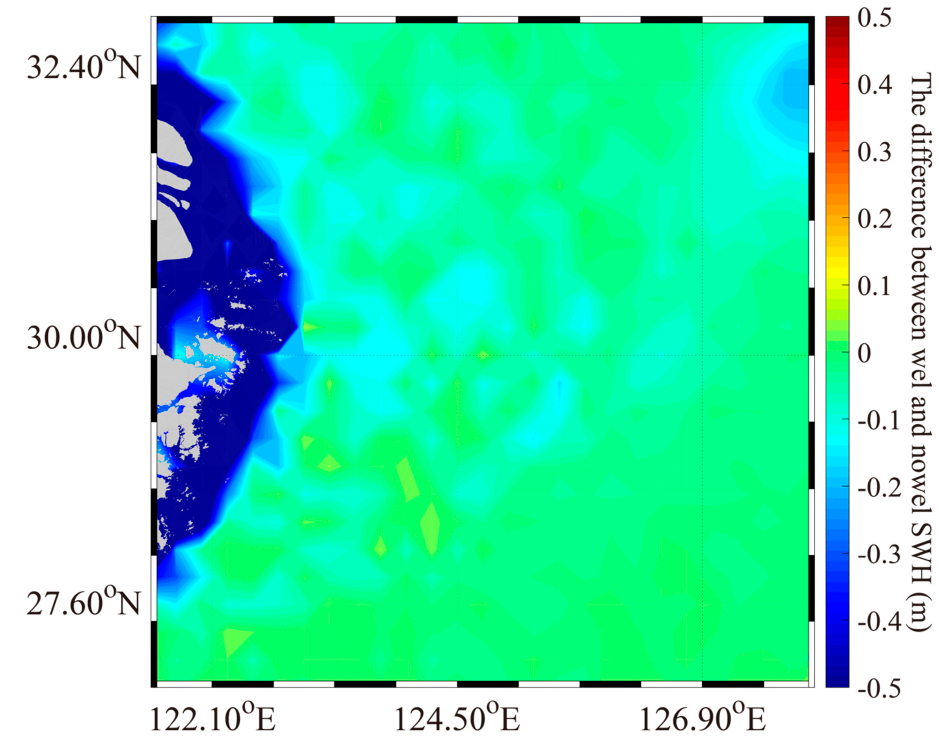
Figure 12. Difference between simulated results from the SWAN model under two conditions (significant wave height (SWH) without sea-water level minus SWH with sea-water level) at 14:00 UTC on 22 September 2014.